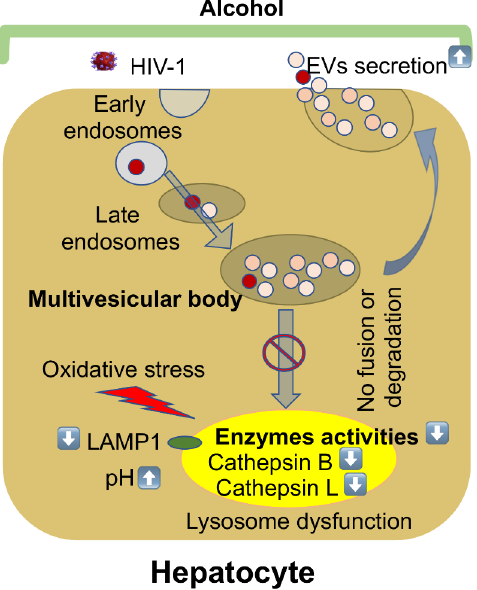
Figure 6. Alcohol stimulates EVs release from HIV-infected hepatocytes by impairing lysosomal function. The maturation of early endosomes results in the formation of late endosomes/mul- tivesicular bodies (MVBs). MVBs that contain many intraluminal vesicles either release EVs by fusion with the plasma membrane, or their contents are degraded if they fuse with lysosomes. Alcohol increases oxidative stress, and lysosomal pH suppresses lysosomal enzyme activities and LAMP1 protein expression in HIV-infected hepatocytes that impair the fusion or degradation of multivesicular bodies to the lysosome, finally leading to an increase in EVs’ release. 5. Conclusions In summary, our data demonstrate that ethanol metabolism and mainly acetalde- hyde causes oxidative stress in HIV-infected hepatocytes. This results in lysosome impair- ment associated with decreasing cathepsin activities and downregulation of lysosome protein markers, which, in turn, potentiates EVs release from the hepatocytes. We believe that these results contribute to further understanding underlying mechanisms associated with lysosome impairment and EVs secretion in HIV-induced liver disease progression in alcohol-abusing PLWH.